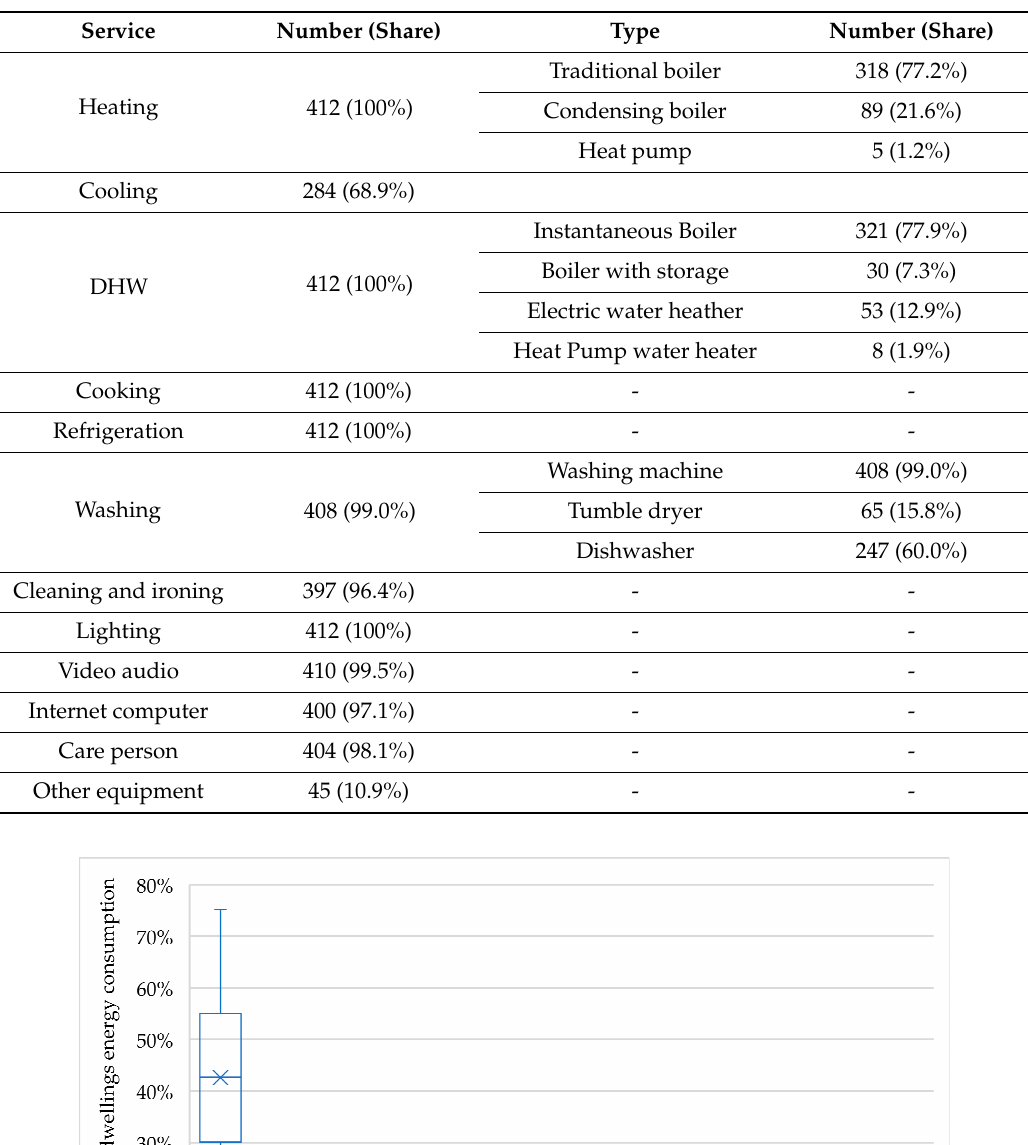
Table 3. Services spread within homes.